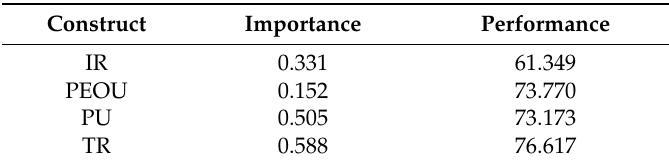
Table 7. Importance-Performance Map Analysis